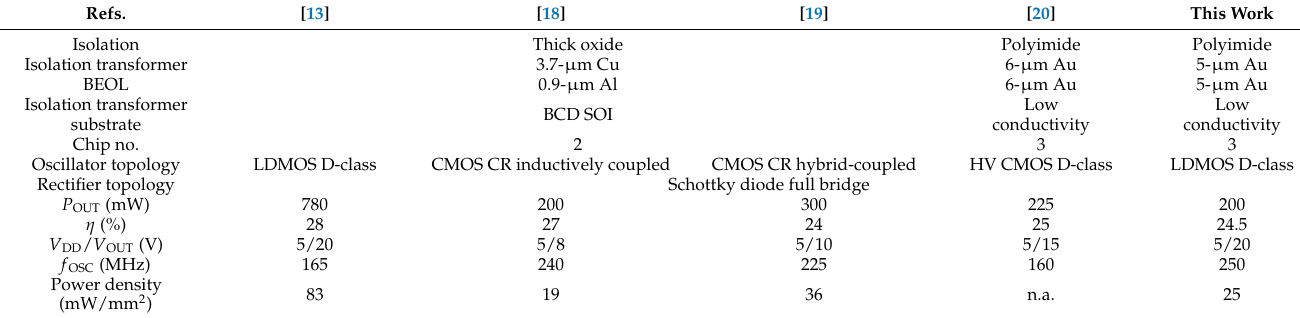
Table 4. State of the art of isolated DC-DC converters for HV/MV applications (basic isolation).